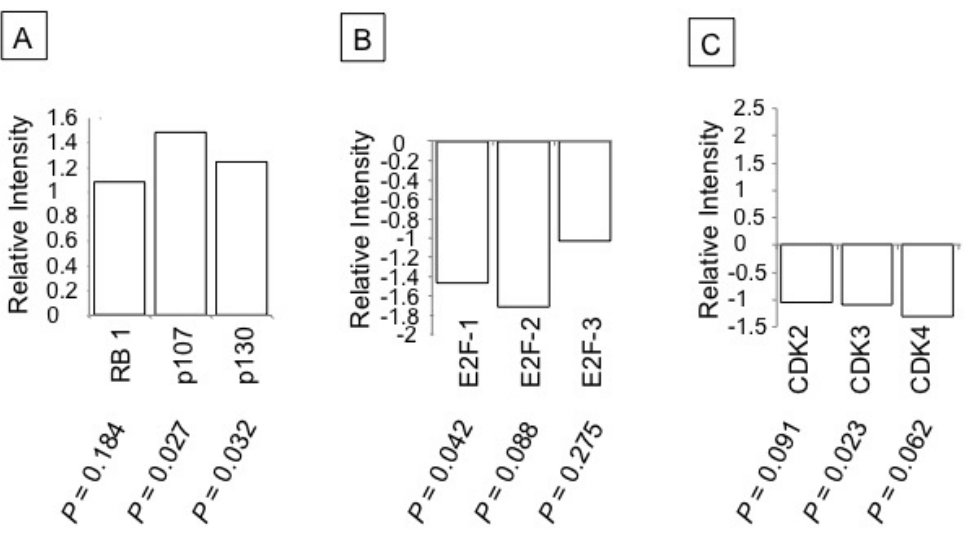
Figure 3. Effect of ritonavir on cell cycle genes of PANC-1 cells: PANC-1 cells treated with 25 µM ritonavir for 48 h were harvested and total RNA was isolated to generate cRNA. The cRNA was then hybridized to Whole Human Genome (G4112A) arrays according to the manufacturer’s protocol. ( A – C ) Gene expression of indicated cell cycle regulatory proteins. Relative Intensity: Ratio of expression of mRNA transcripts in ritonavir-treated PANC-1 cells versus the mock (DMSO)-treated PANC-1